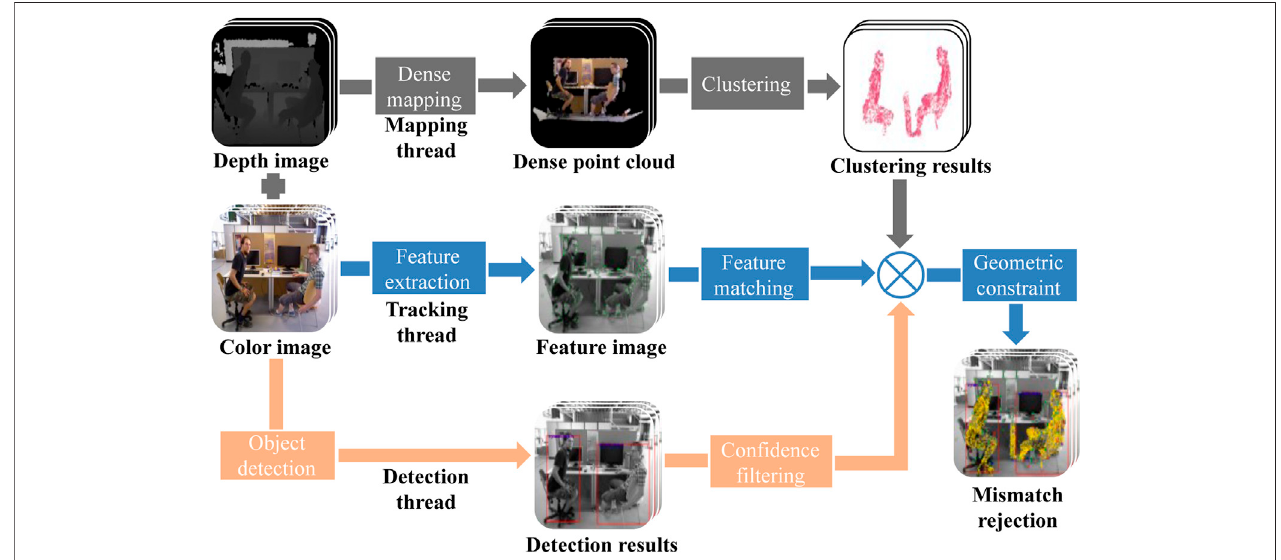
FIGURE 1| The framework ofthe combined mismatch rejection algorithm, among which the tracking thread is as same asthe originalalgorithm and the other two presented threads are added in the system.